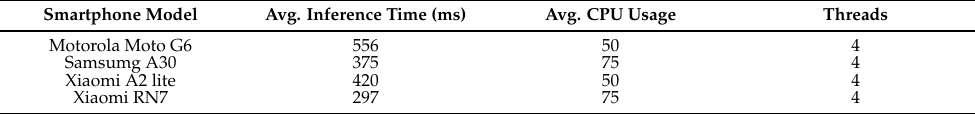
Table 6. Tensorflow Lite app on recent cluster smartphones: benchmark results. Smartphone